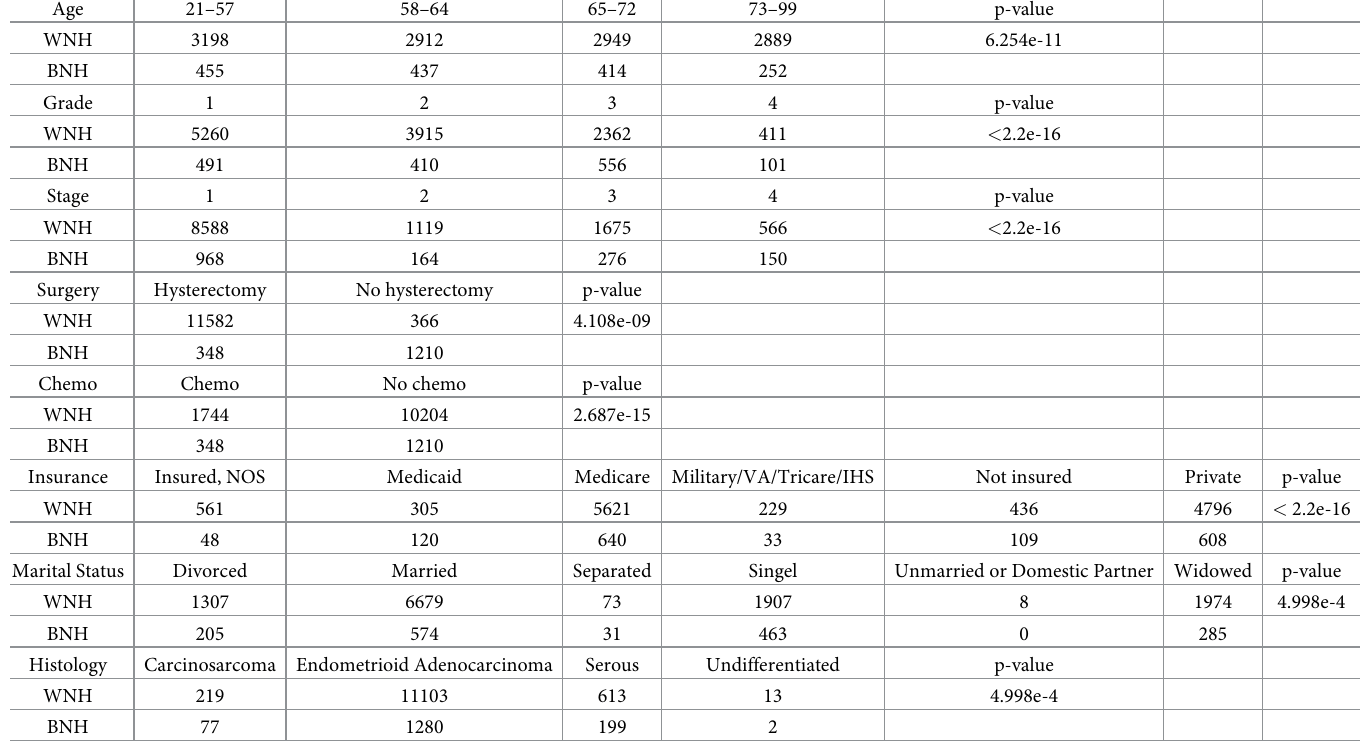
Table 1. Overall racial differences across individual level